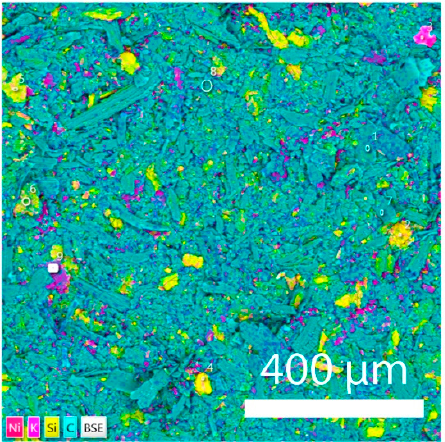
Figure 6. Full multilayer EDS map of wheat straw powder .